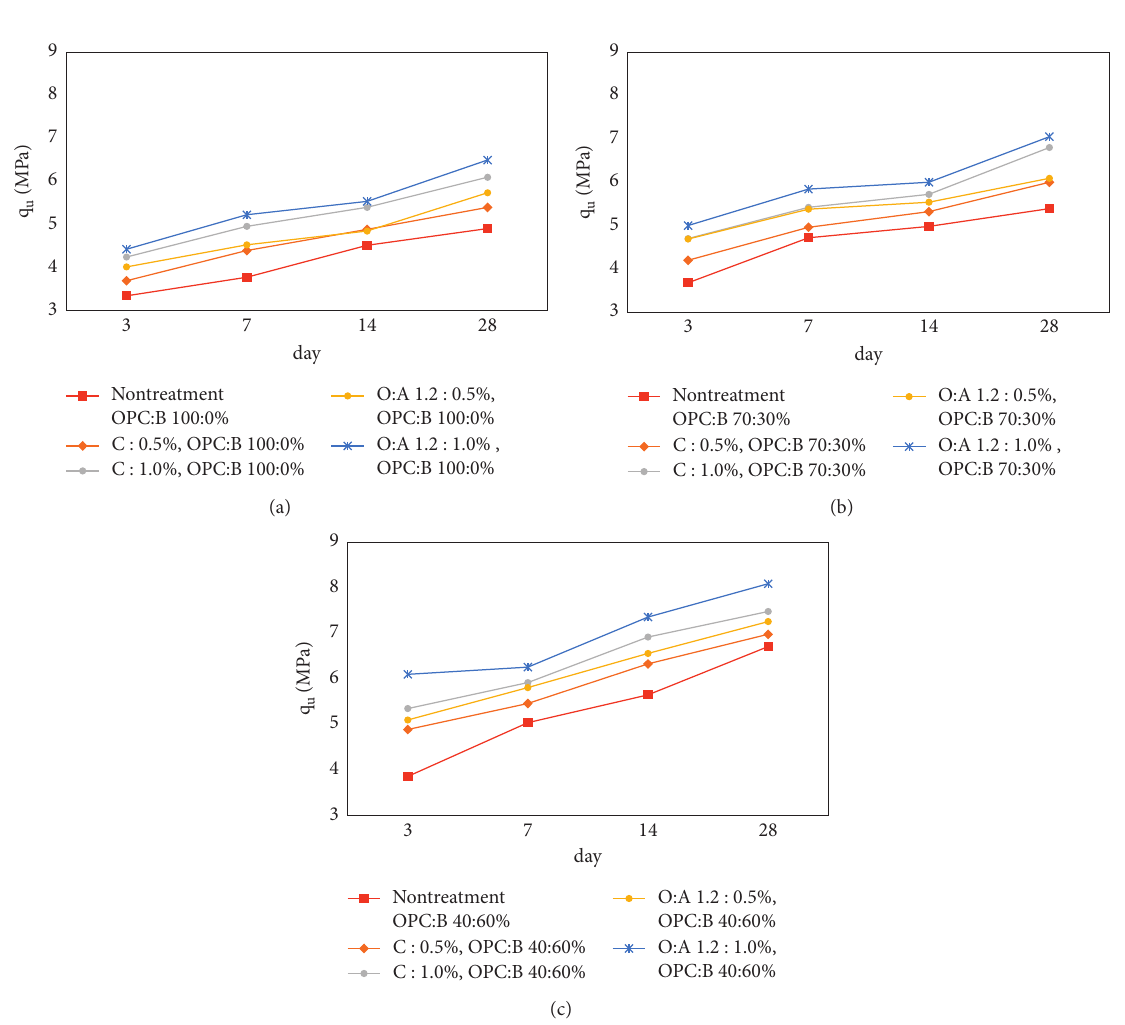
Figure 6: Analysis of uniaxial compressive strength by fiber contents: (a) results of uniaxial compressive test for OPC: B � 100: 0%; (b) results of uniaxial compressive test for OPC: B � 70 :30%; (c) results of uniaxial compressive test for OPC: B � 40: